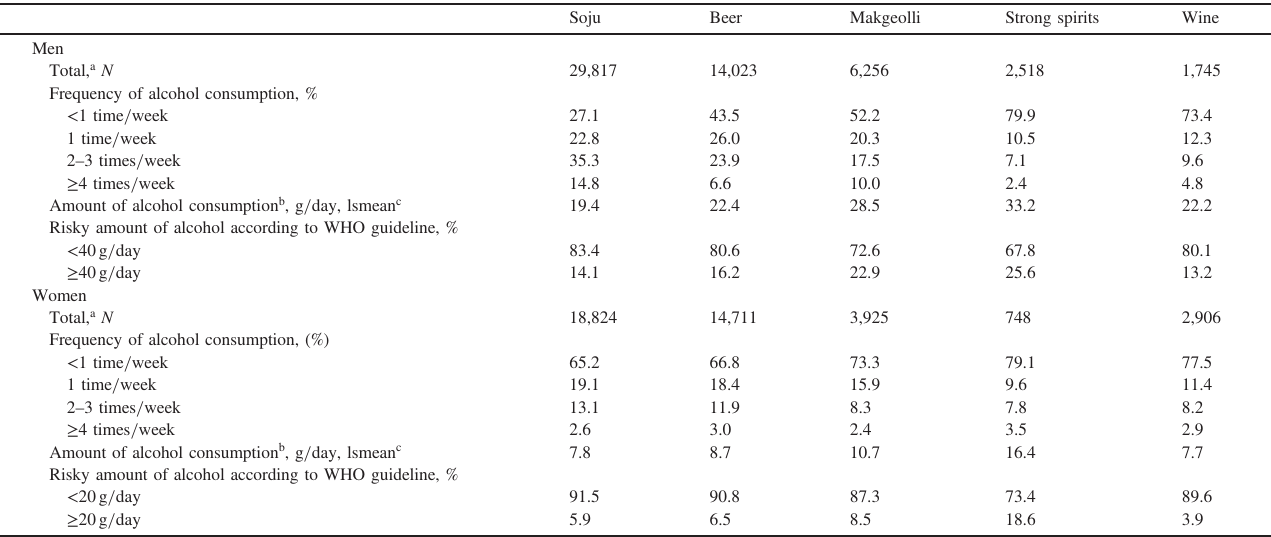
Table 1. Frequency of consuming each type of alcoholic beverage and total alcohol consumption according to the types of alcoholic beverages consumed by 58,977 current drinkers (32,475 men and 26,502 women) aged 40 – 69 in the HEXA-G study Soju Beer Makgeolli Strong spirits Wine Men Total, a N 29,817